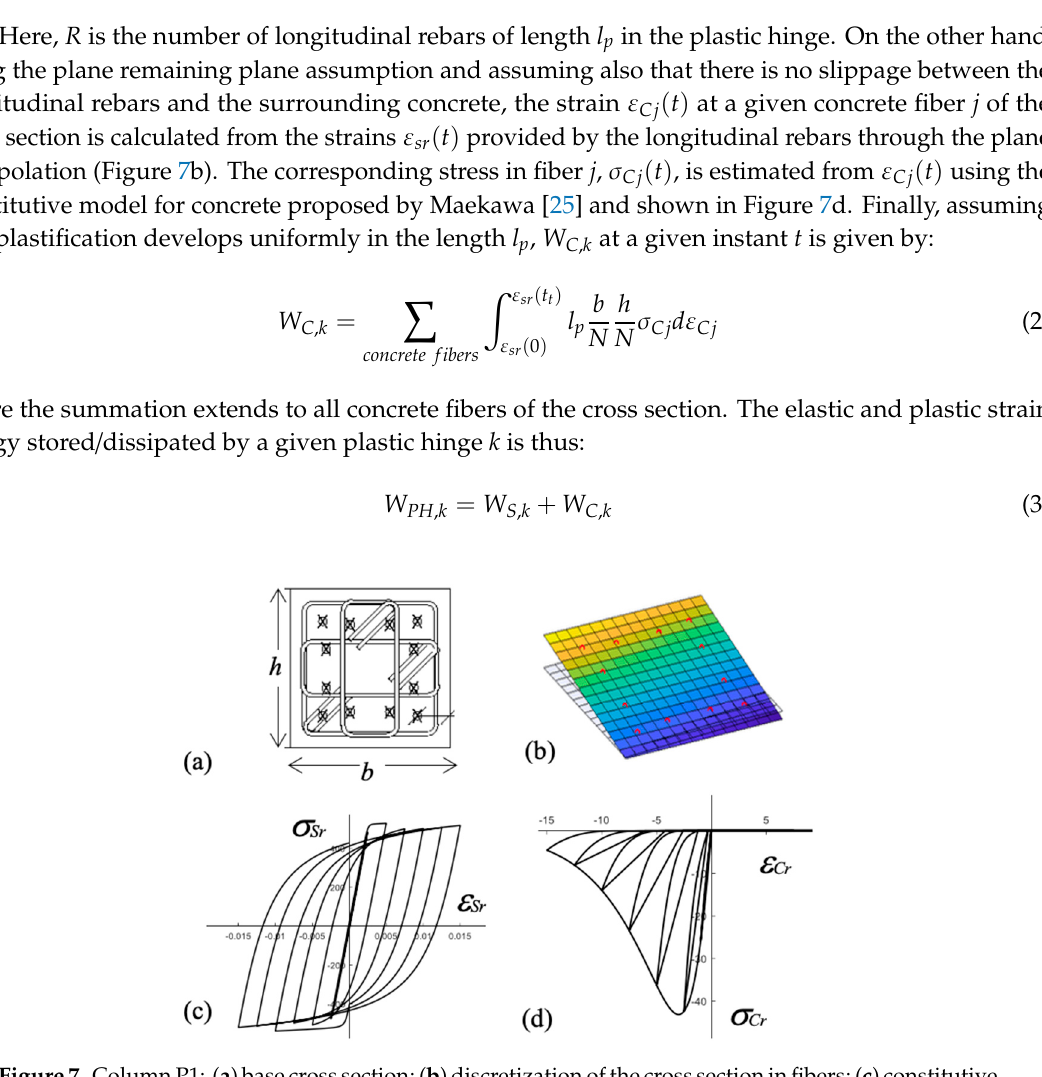
Figure 7. Column P1: ( a ) base cross section; ( b ) discretization of the cross section in fibers; ( c ) constitutive model for steel; ( d ) constitutive model for concrete. 206